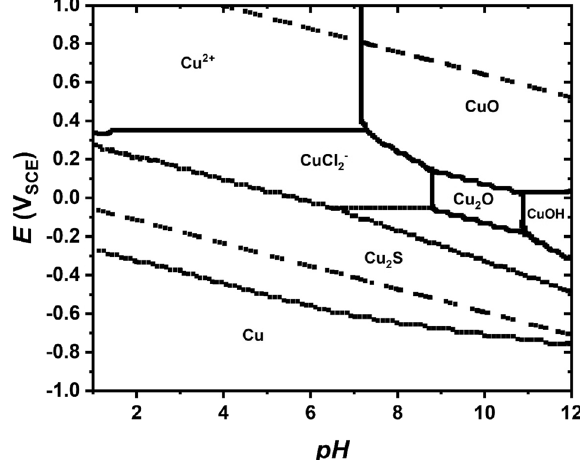
– pH equilibrium) diagram of Cu in DGR system. Cu: 1E − 9 mol m − 3 , Na + : 0.1 mol m − 3 , Cl − : 0.1 mol m − 3 , HS − : 0.001 mol·m -3 , and T = 25 °C